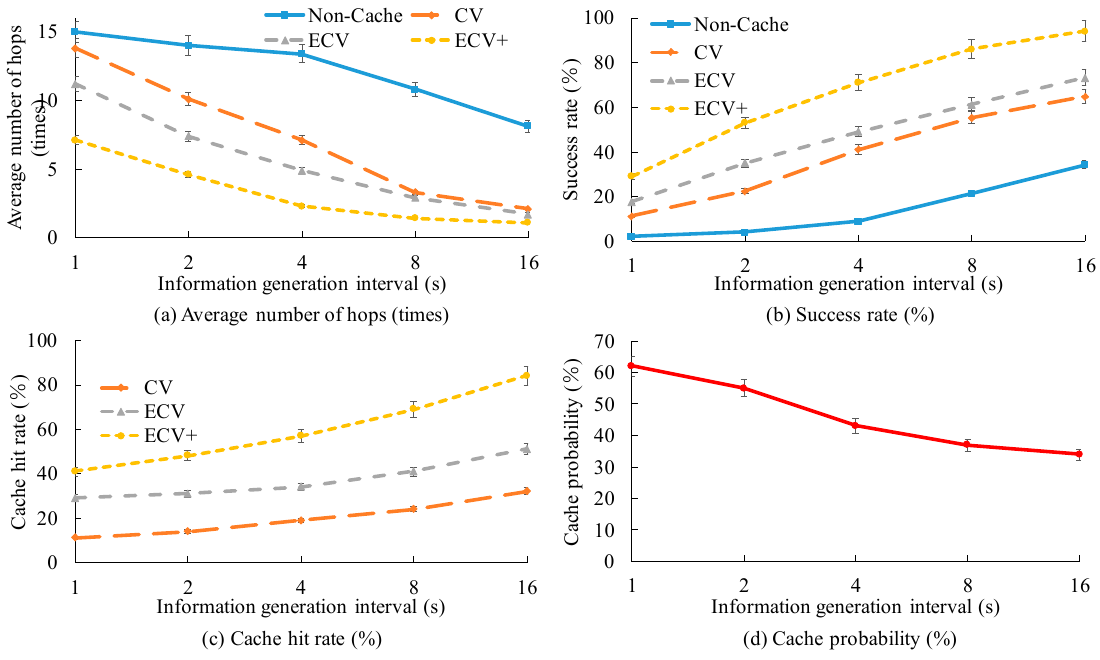
Figure 7. Results under different information generation intervals (cache buffer capacity is 100 GB and the number of vehicles is 500).